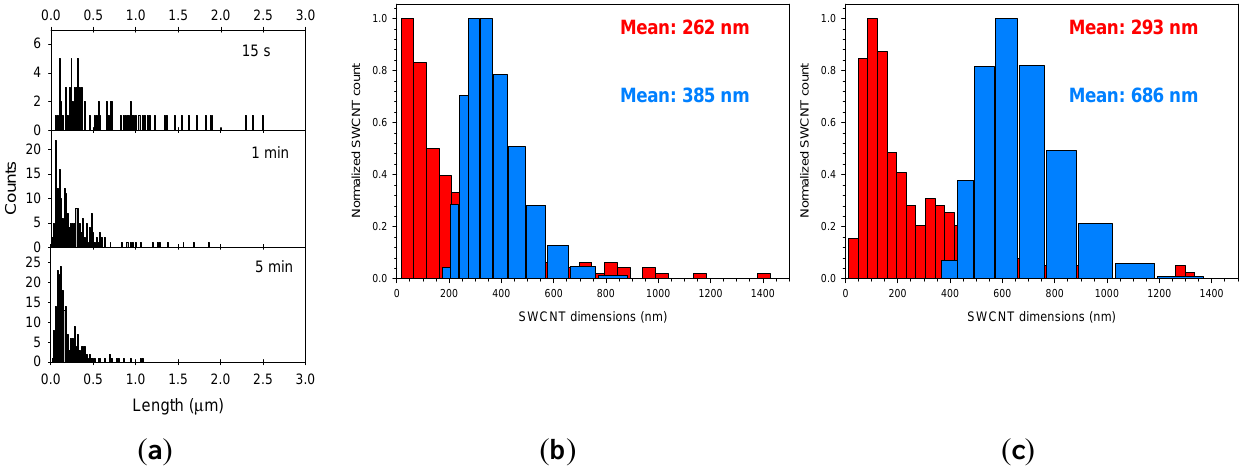
Figure 1. ( a ) AFM length analyses of siRNA/SWCNT complexes sonicated for 15 seconds, 1 min or 5 min; (b,c) AFM (red) and DLS (blue) length distribution and means